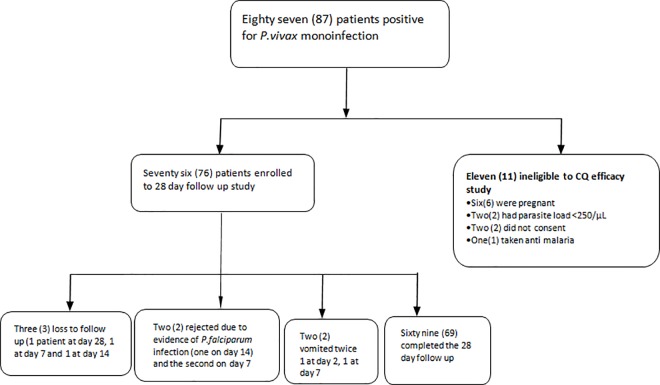
Patient recruitment and follow-up for the trial of CQ efficacy against P. vivax malaria in Bullen Health Centre Northwest Ethiopia (17 August to 19 December, 2014).